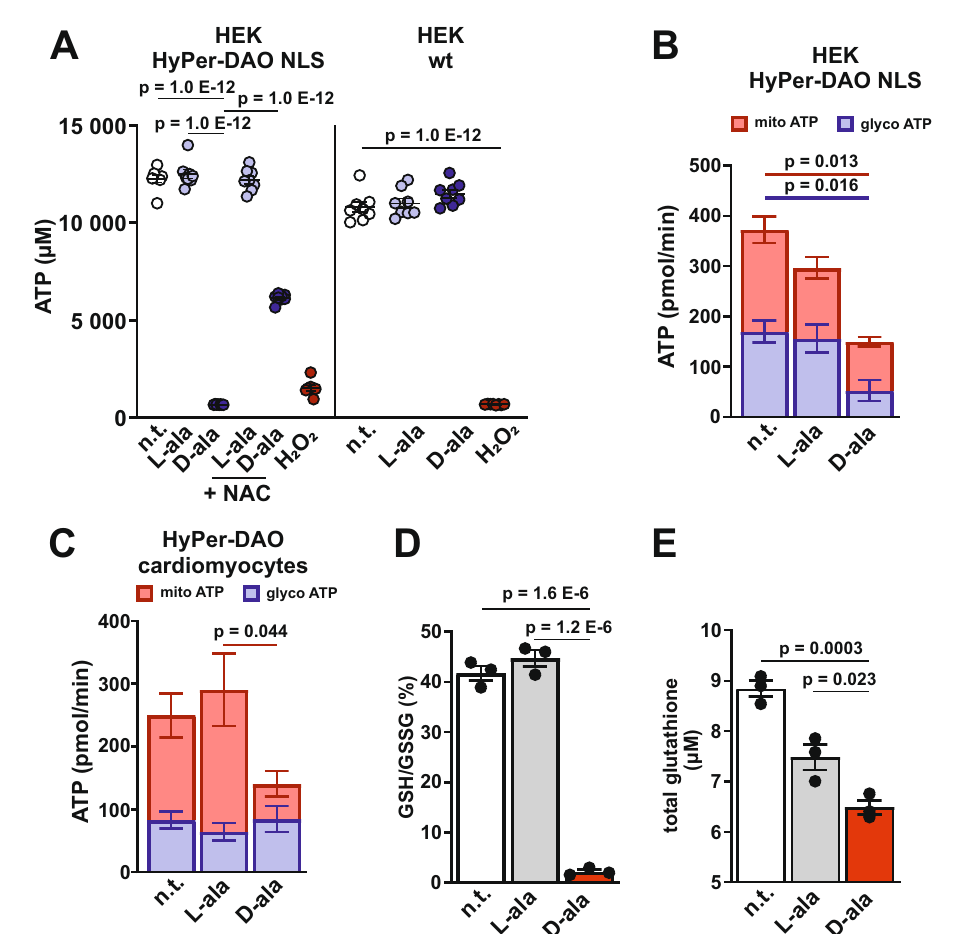
Fig. 4 | HyPer-DAO overexpressing HEK cells exhibit a reversible redox mod- i fi cationandactivityofIDH3afteractivationofDAOinvitro.A Confocalimages of HEK cells overexpressing the HyPer-DAO fusion protein in the nucleus (HyPer- DAO-NLS), the cytoplasm (HyPer-DAO-NES) or the mitochondrial matrix (HyPer- DAO-MLS) after the indicated staining. The staining has been performed once. B HyPer fl uorescence response in HyPer-DAO overexpressing HEK cells to treat- mentwithL-ala,D-alaorH 2 O 2 (addedattimepoint4min).Ratiosarenormalizedto the HyPer ratio prior to the stimulation, n =30 independent cells per condition were analyzed except than n =25 independent HyPer-DAO-NES and HyPer-DAO- NLScellstreatedwith500 µ MH 2 O 2 ,seealsoSupplementalFig.2. C IDH3activityin cell extracts obtained from HEK HyPer-DAO-NES, HEK HyPer-DAO-NLS and HEK HyPer-DAO-MLS cells non-treated (n.t.) and after treatment with 50mM D-ala, 50 mM L-ala ± 8mM NAC or 500 µ M H 2 O 2 for 20min. n =8 independent experiments for HyPer-DAO-NES all conditions; n =6 independent experiments for HyPer-DAO- NLS and HyPer-DAO-MLS all conditons except for n =5 for L-ala and D-ala + NAC, see also SupplementalFig.3. D HyPer fl uorescence (left panel) and MitoSOX (right panel)responseinHyPer-DAO-NLScellstotreatmentwithL-ala,D-ala±NAC(added